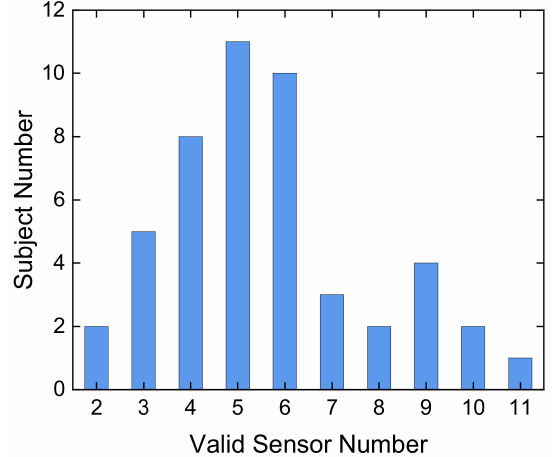
Figure 13. Summary of the pulse width measurements. A total of 48 participants were assessed. It is impossible to measure the minimum pulse width using a pressure-sensor array.